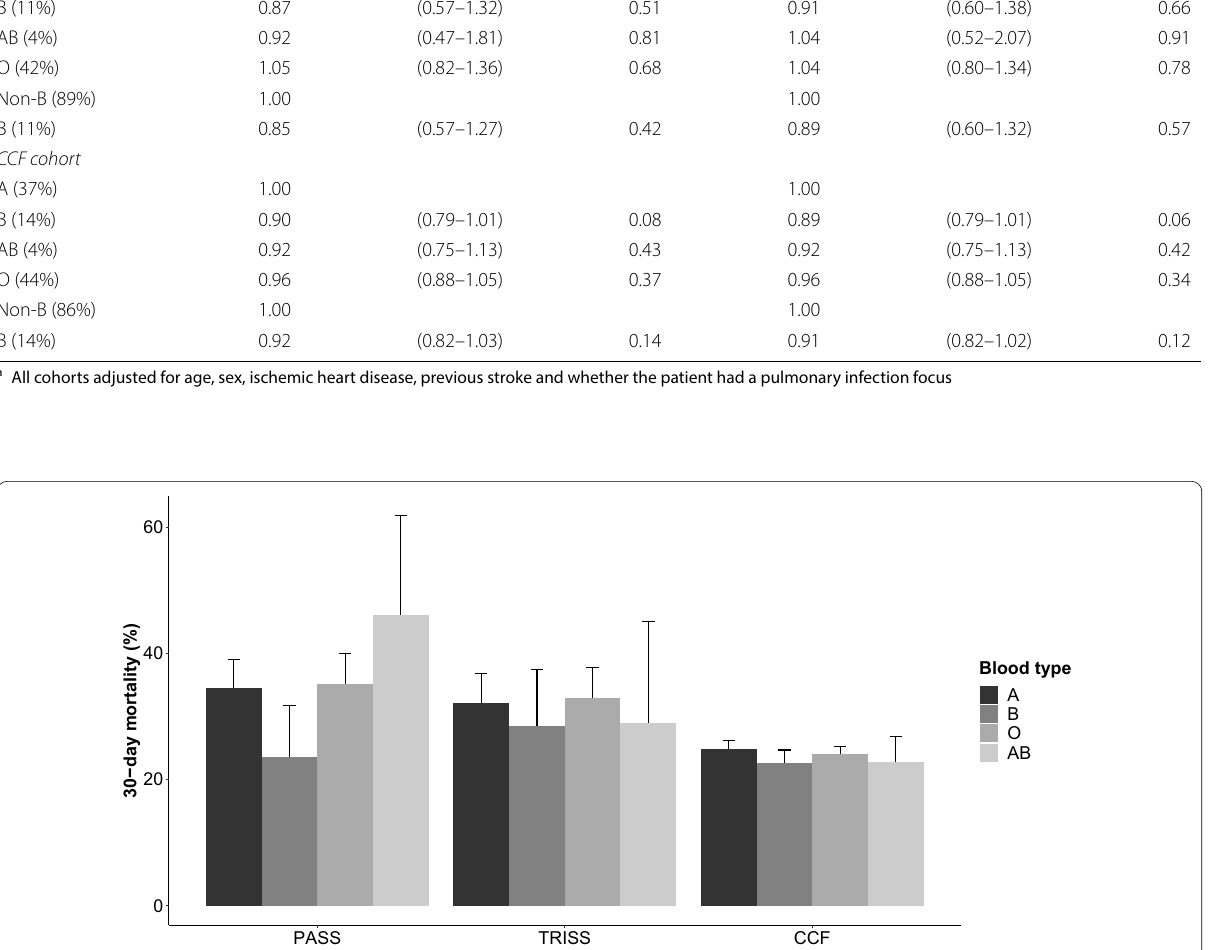
A (Additional file 2: Table S2). When comparing B to non-B blood types no difference was found.